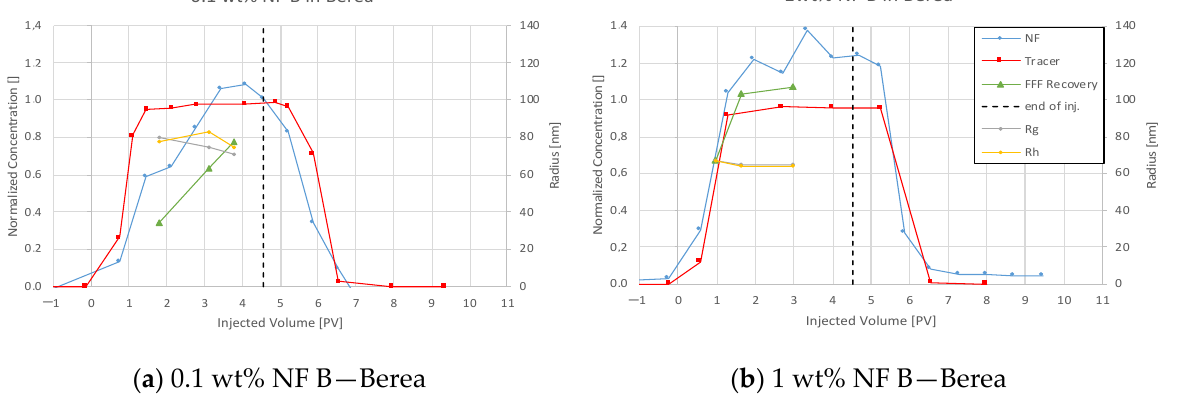
Figure 11. Effluent analysis for NF B in for 0.1 wt% ( a ) and 1 wt% ( b ) in TW in Berea sandstone. The calculated maximum concentration exceeds the injected concentration. The nanofluid shows only a slightly delayed breakthrough compared to the tracer. In the first injection step, the nanofluid shows a delayed breakthrough forming a peak at 0.11 wt%. Effluent concentration decreases faster compared to the tracer.